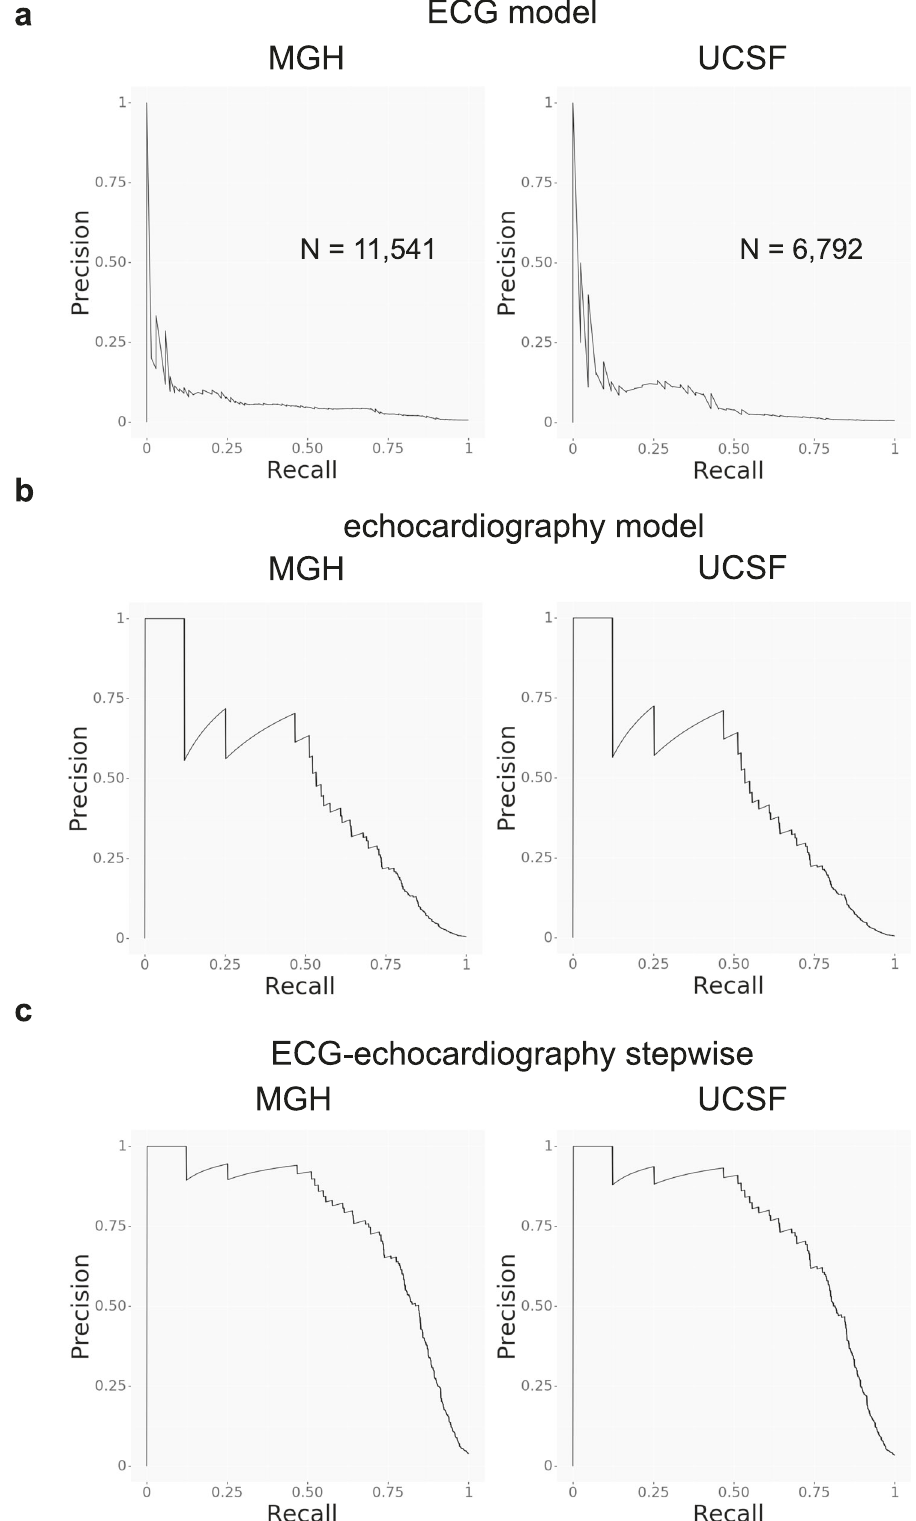
Fig. 5 Screening performance of the models on surveillance populations. Precision recall curve plots for a the ECG model, b the echocardiography model, and c the echocardiography model after ECG pre-screening for detection of cardiac amyloidosis in surveillance populations. N is the numbers of studies. Source data are provided as a Source Data fi le. MGH: Massachusetts General Hospital, UCSF: University of California San Francisco, ECG: